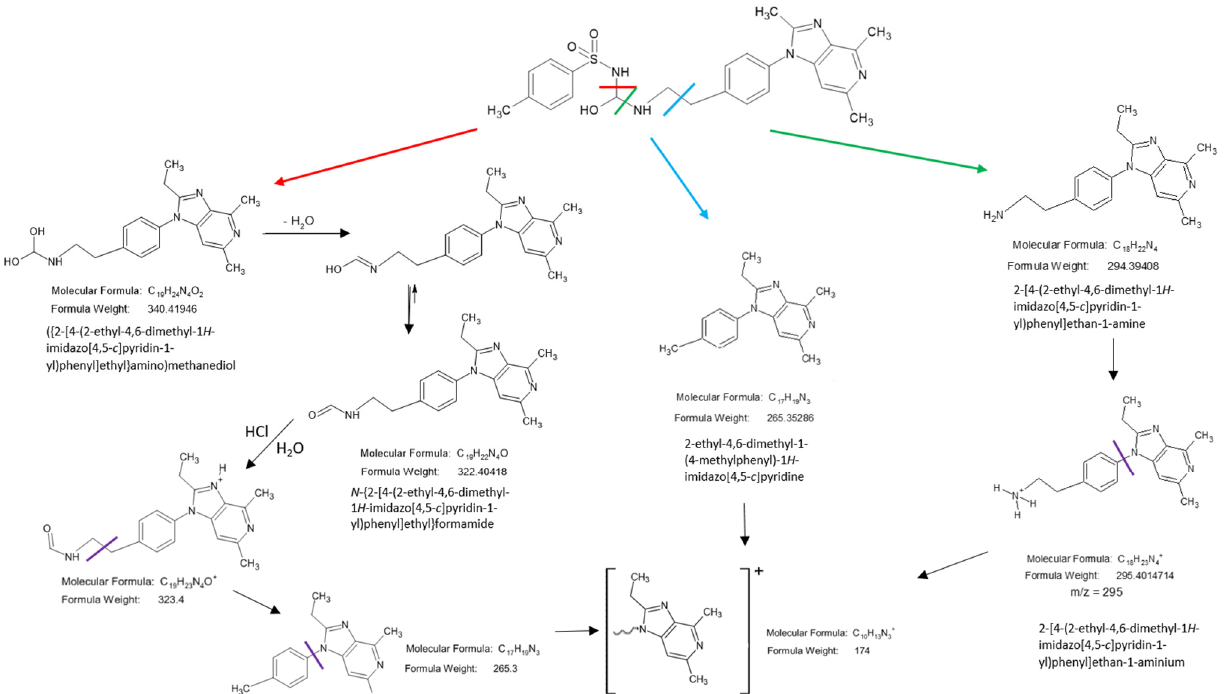
Figure 9. Structures and possible fragmentation pattern of grapiprant.